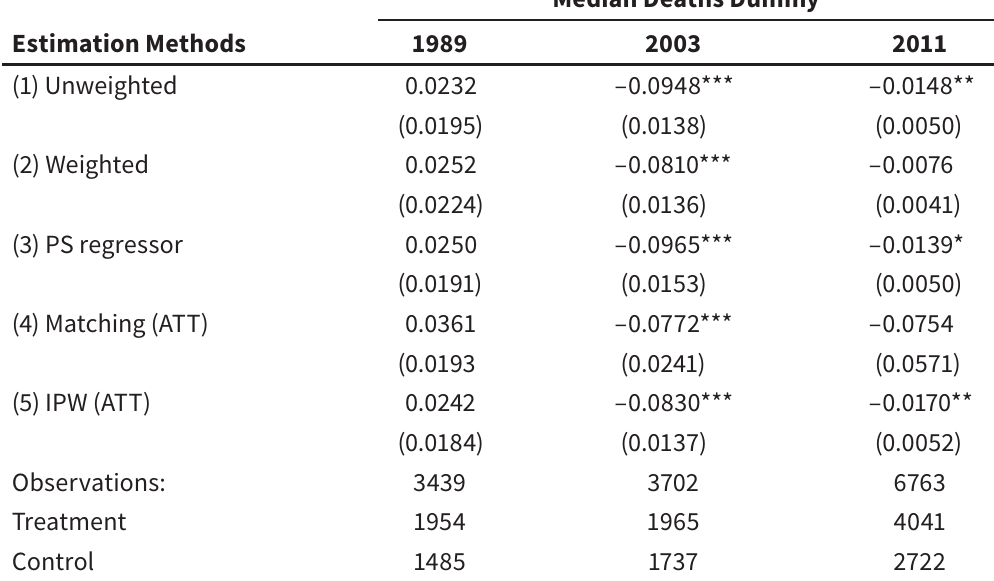
Table A2.14 The Impact of Conflict on the Gini Coefficient using Interaction between Main Conflict Exposure measure and Conflict Deaths per Chiefdom Above Median Conflict Exposure Interacted with the